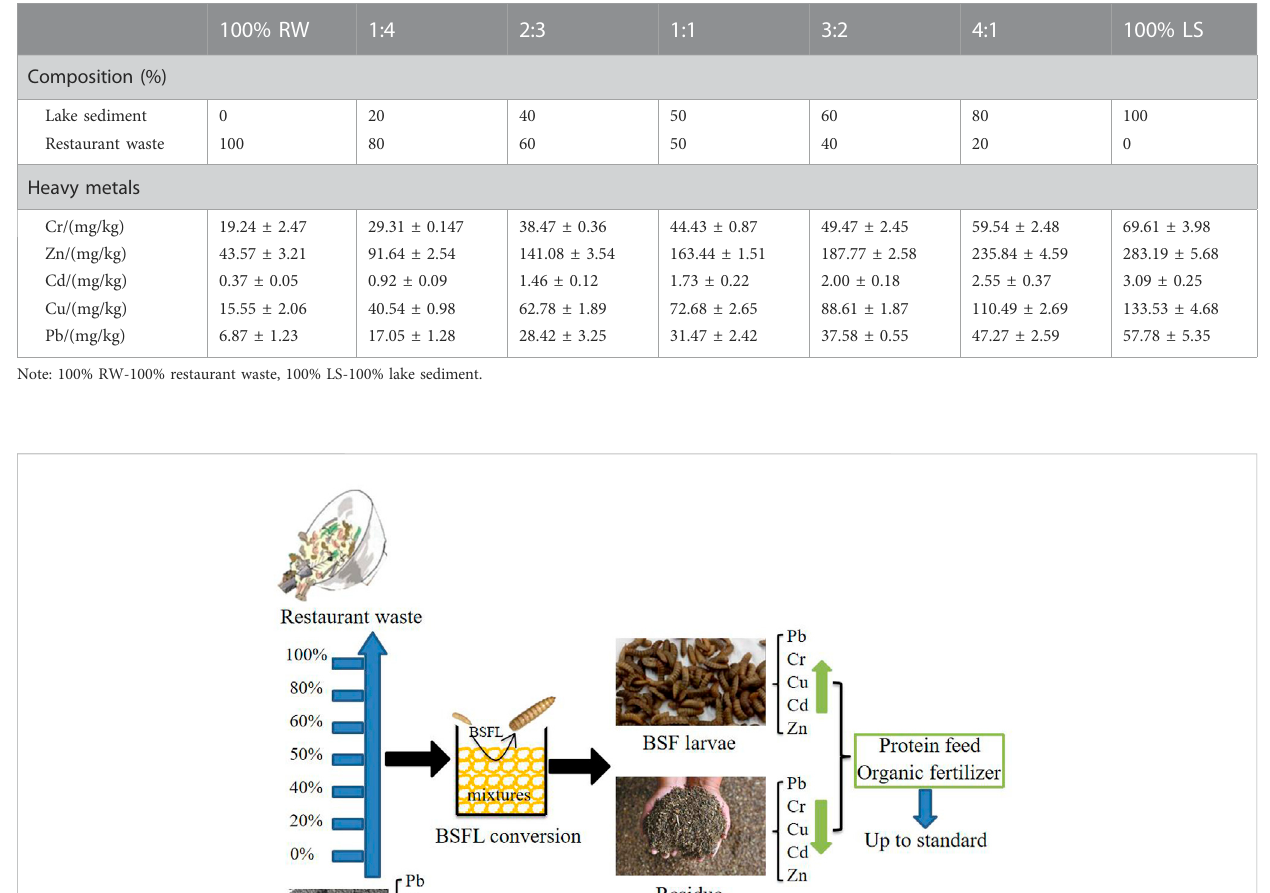
TABLE 2 Initial content of heavy metals in experiment groups.